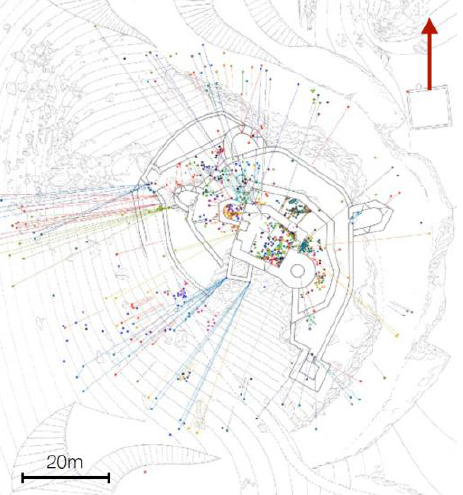
Figure 2: Location plan of inventoried blocks (Mathias Heissler, 2007); each color represents a specific “series” of blocs